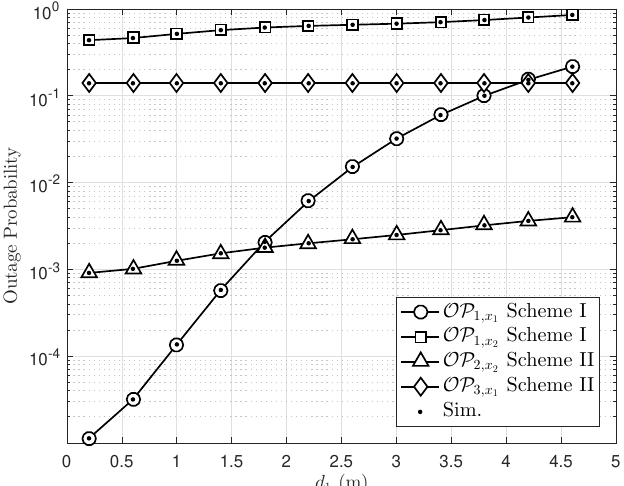
Figure 7. The impact of relay location on outage probability with N S = 2, N D = 2, P S = 20 dB, a 1 = 0.2 and a 2 =